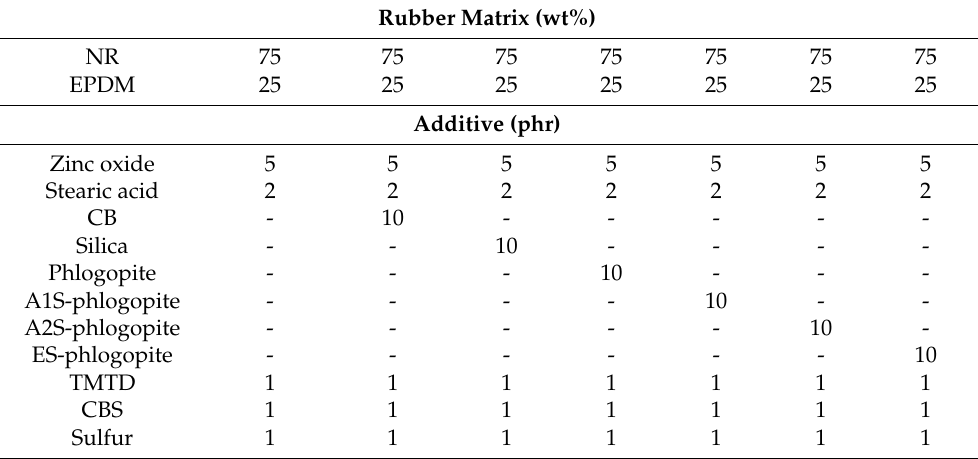
Table 1. Recipes of the rubber compounds.